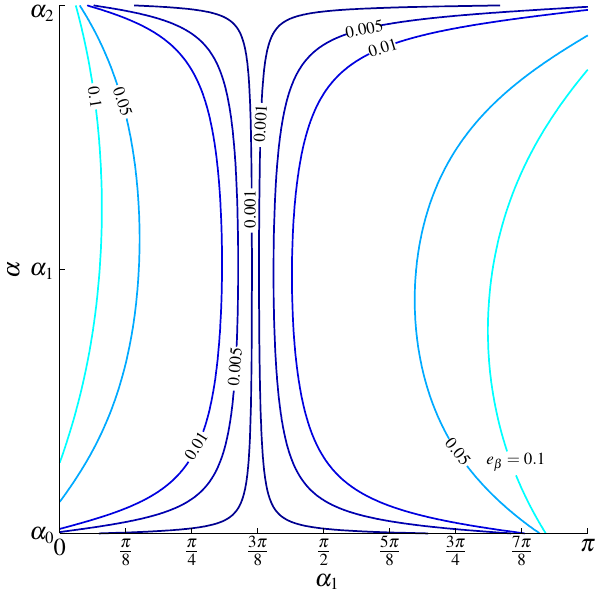
Figure 5. Coordination Error e β as a function of the median an- gle α 1 for α 0 ≤ α ≤ α 2 if l 1 / r = 5.